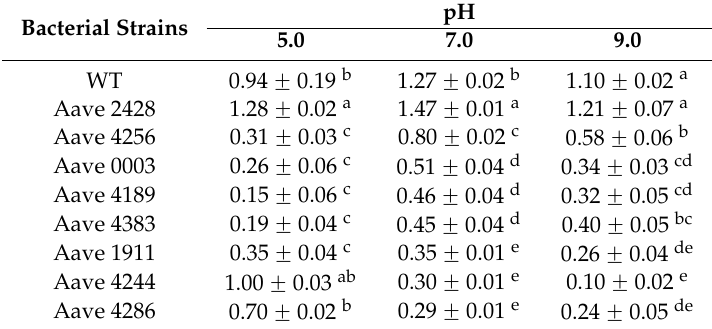
Table 6. Effect of pH on the growth of virulence-related mutants of biofilm-defective strain A1 in LB